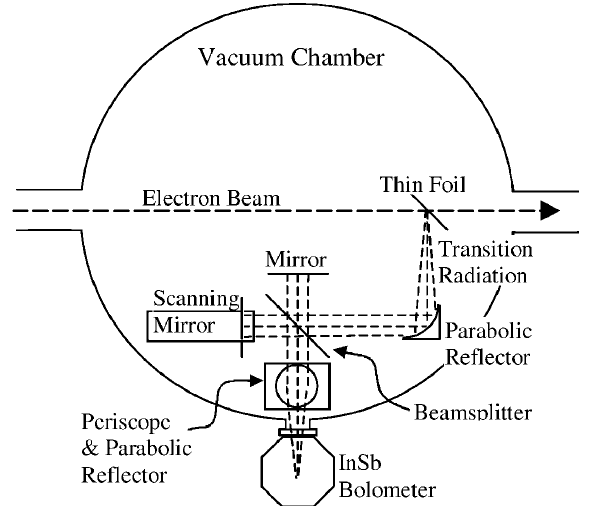
FIG. 3. Schematic diagram of the coherent transition radiation (CTR) measurement apparatus. As the beam passed at 45 ± incidence through a thin, polished aluminum foil, CTR was reflected from the foil into a parabolic mirror, which collimated the CTR and sent it through a Michelson interferometer.